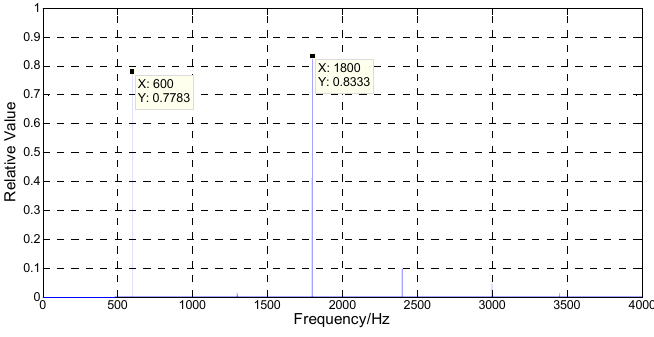
Figure 11. Frequency spectrum of the signal.